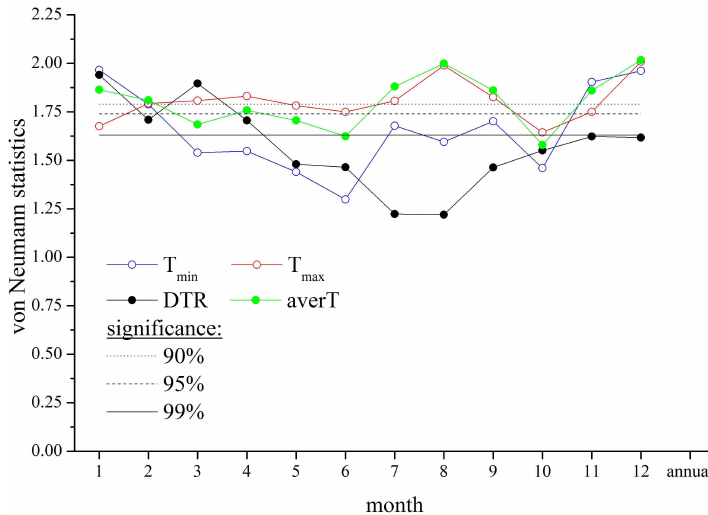
Figure 16. Lisbon: same as Fig. 12 but for the corrected series.